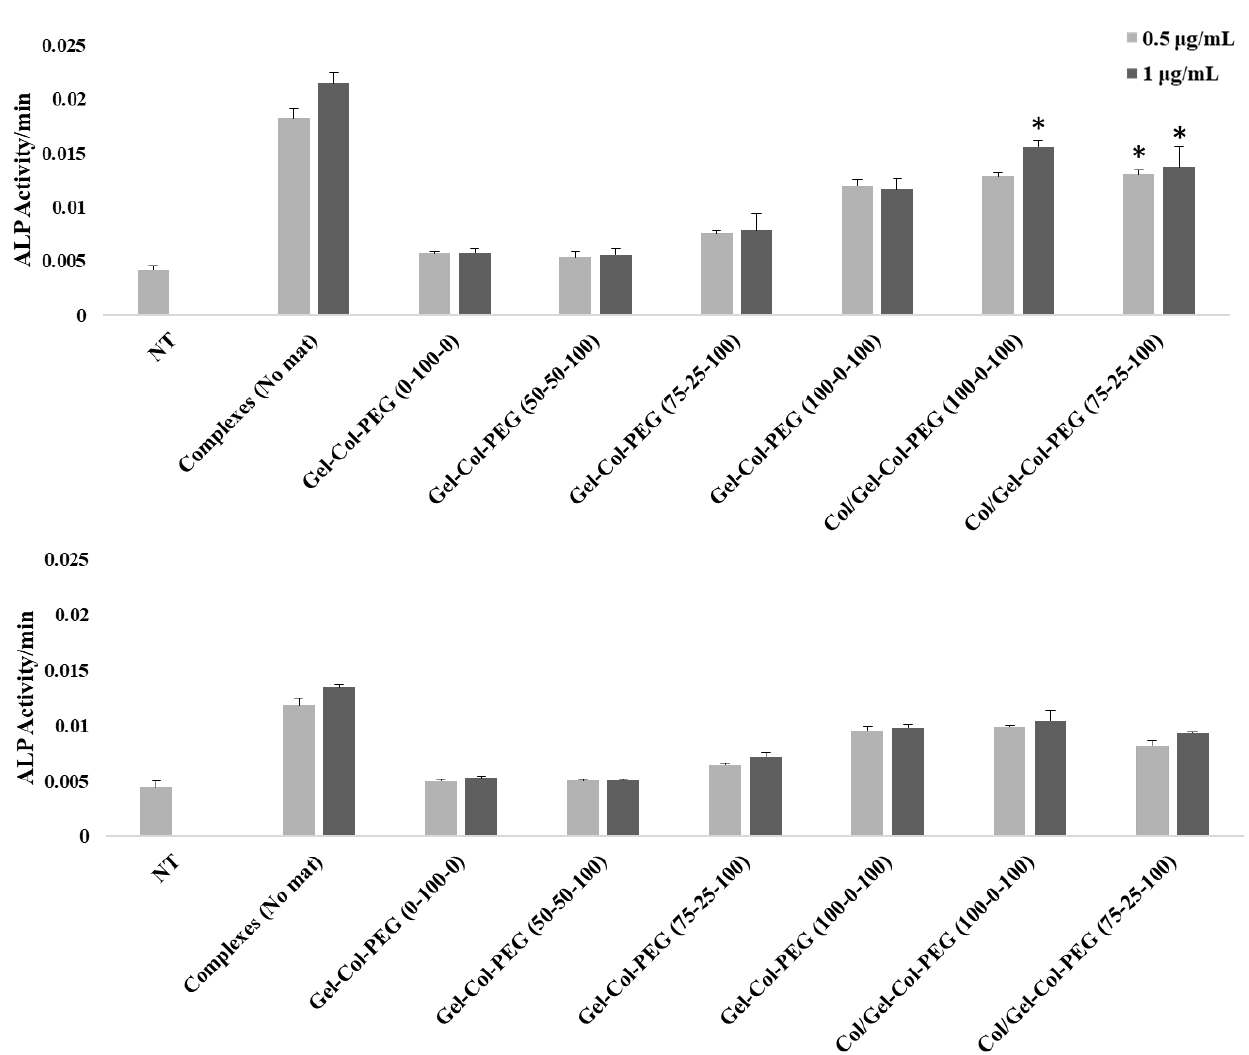
Figure 7. ALP induction in C2C12 cells ( A ) and in MC3T3-E1 ( B ) cells after delivery of gWIZ-BMP-2 complexes from different Gel-Col-PEG monolayer mats and double-layered mats 7 days post transfection. The pDNA concentrations in cell culture were 0.5 and 1.0 μg/mL. The ALP activity was measured 30 min after the addition of the substrate in triplicate. * p < 0.05 compared with monolayer mats .